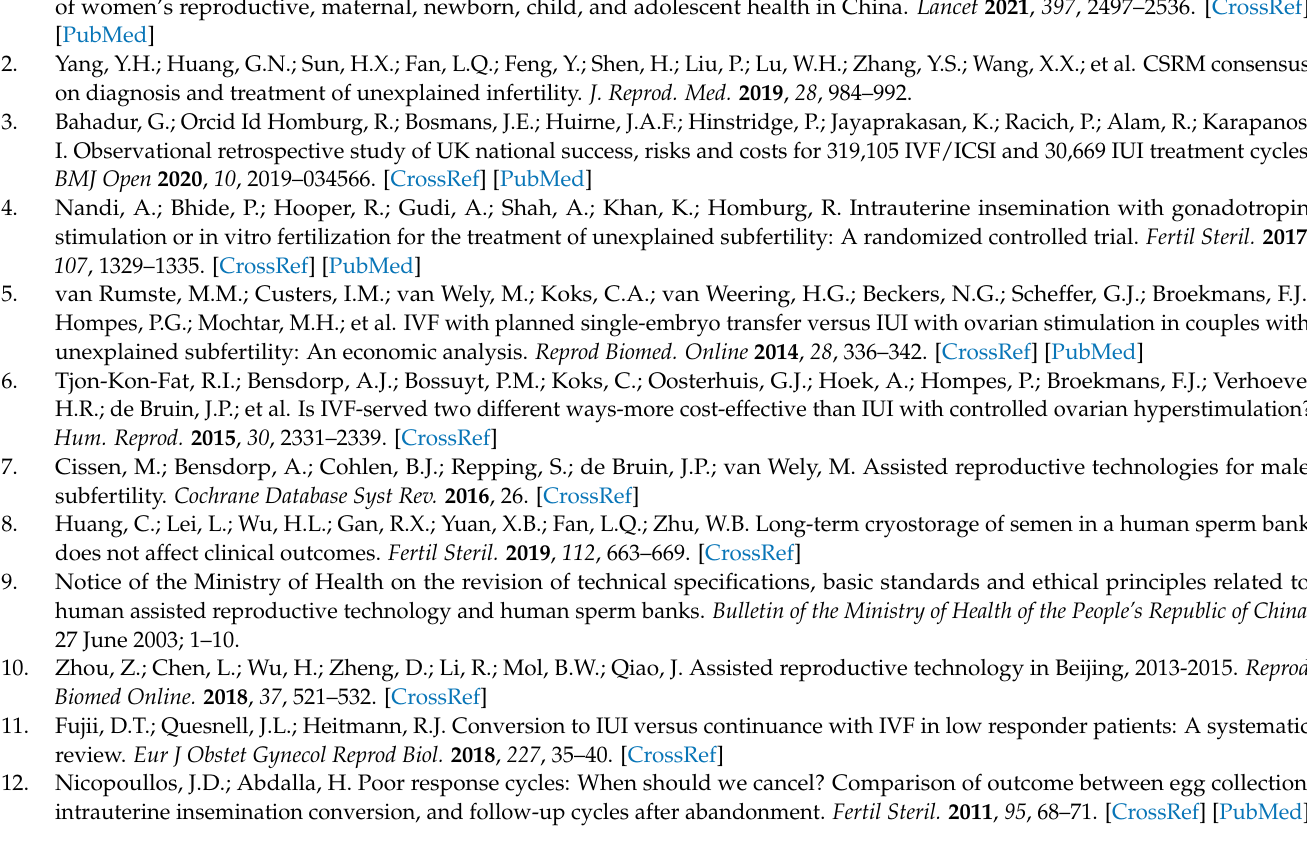
Figure S2: Cycle changes of IVF-D and AI-D treatments; Figure S3: Distribution of sperm dona- tion services of Reproductive and Genetic Hospital of CITIC-Xiangya(Hunan Province Human Sperm